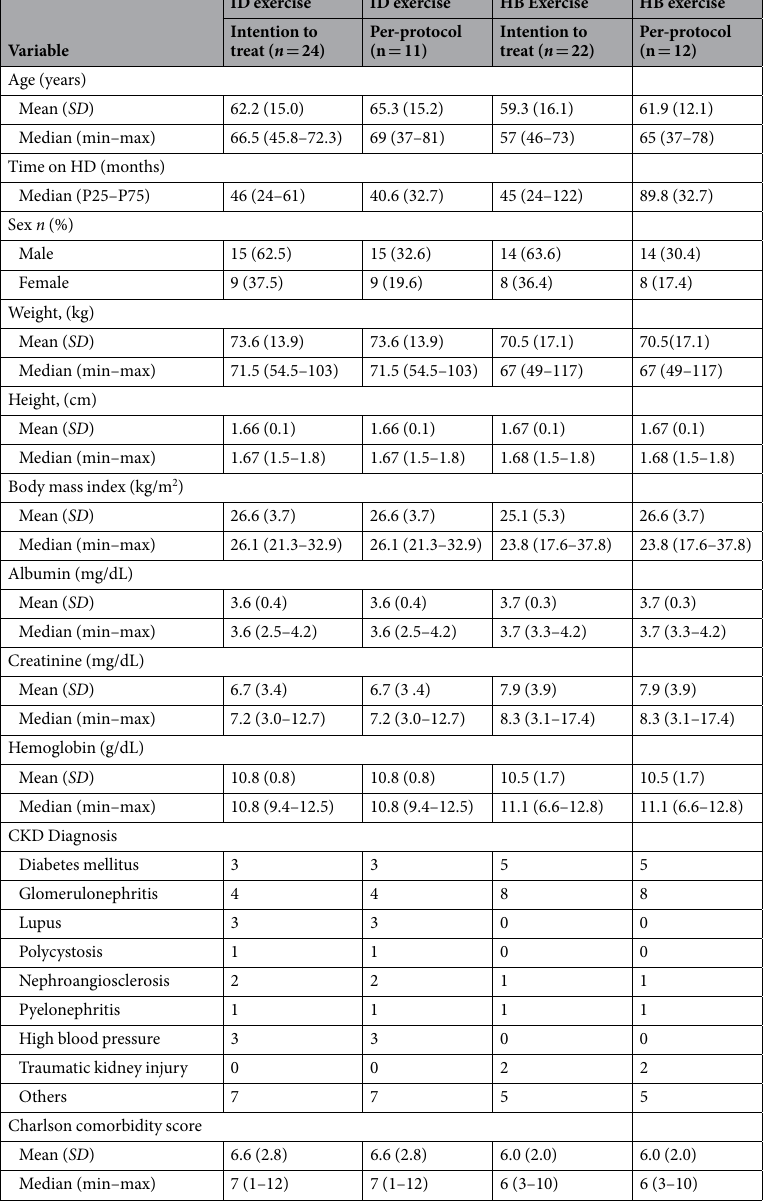
Table 1. Baseline clinical characteristics and demographic data ( n = 46). CKD: chronic kidney disease; SD: standard deviation. Baseline data comparison between intention to treat [ID (n = 24) and HB (n = 22)] or per-protocol groups [ID (n = 11) and HB (n = 12)] with the Mann-Whitney and Chi squared test showed no significant